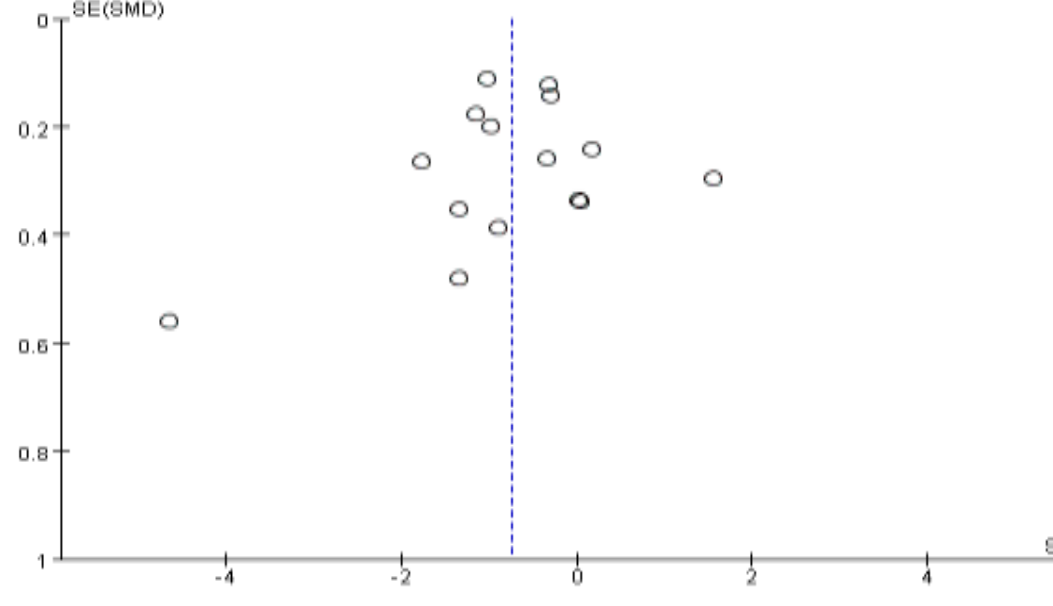
Figure 11. Funnel plot of publication bias.